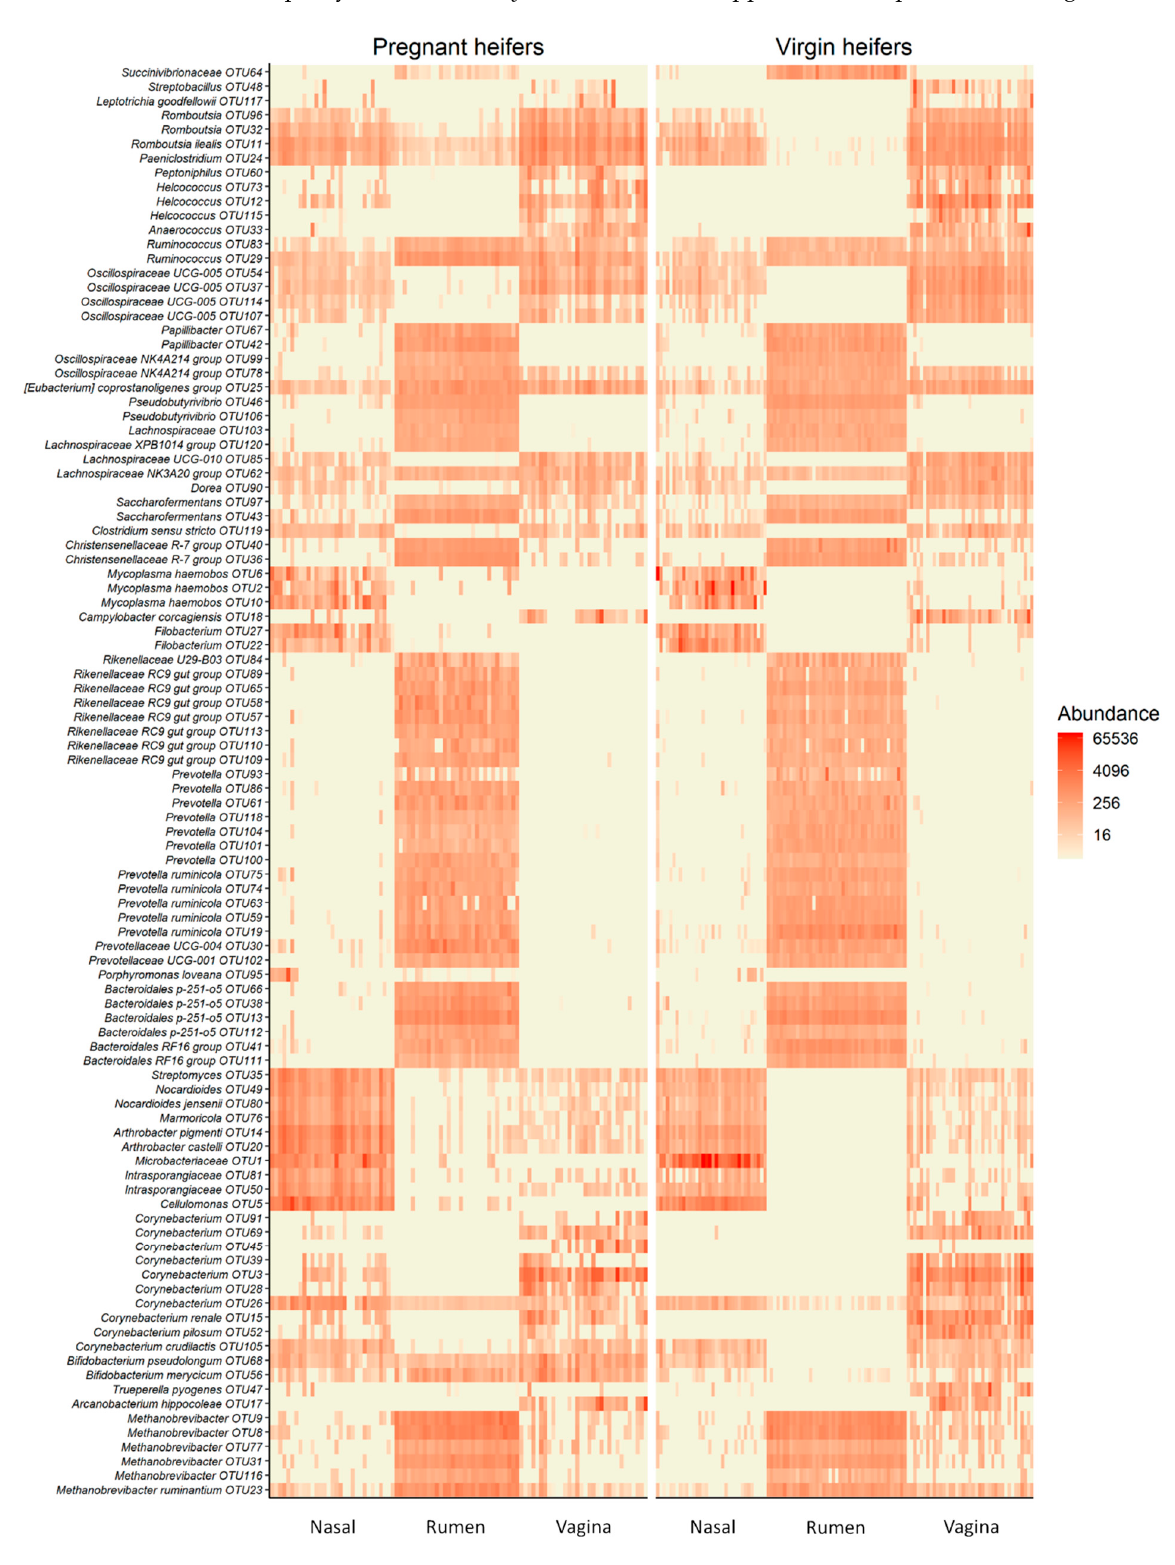
Figure 5. Heat map showing the 100 most abundant OTUs (log 4 ) overall by sample type within each animal group (Pregnant and virgin heifers).